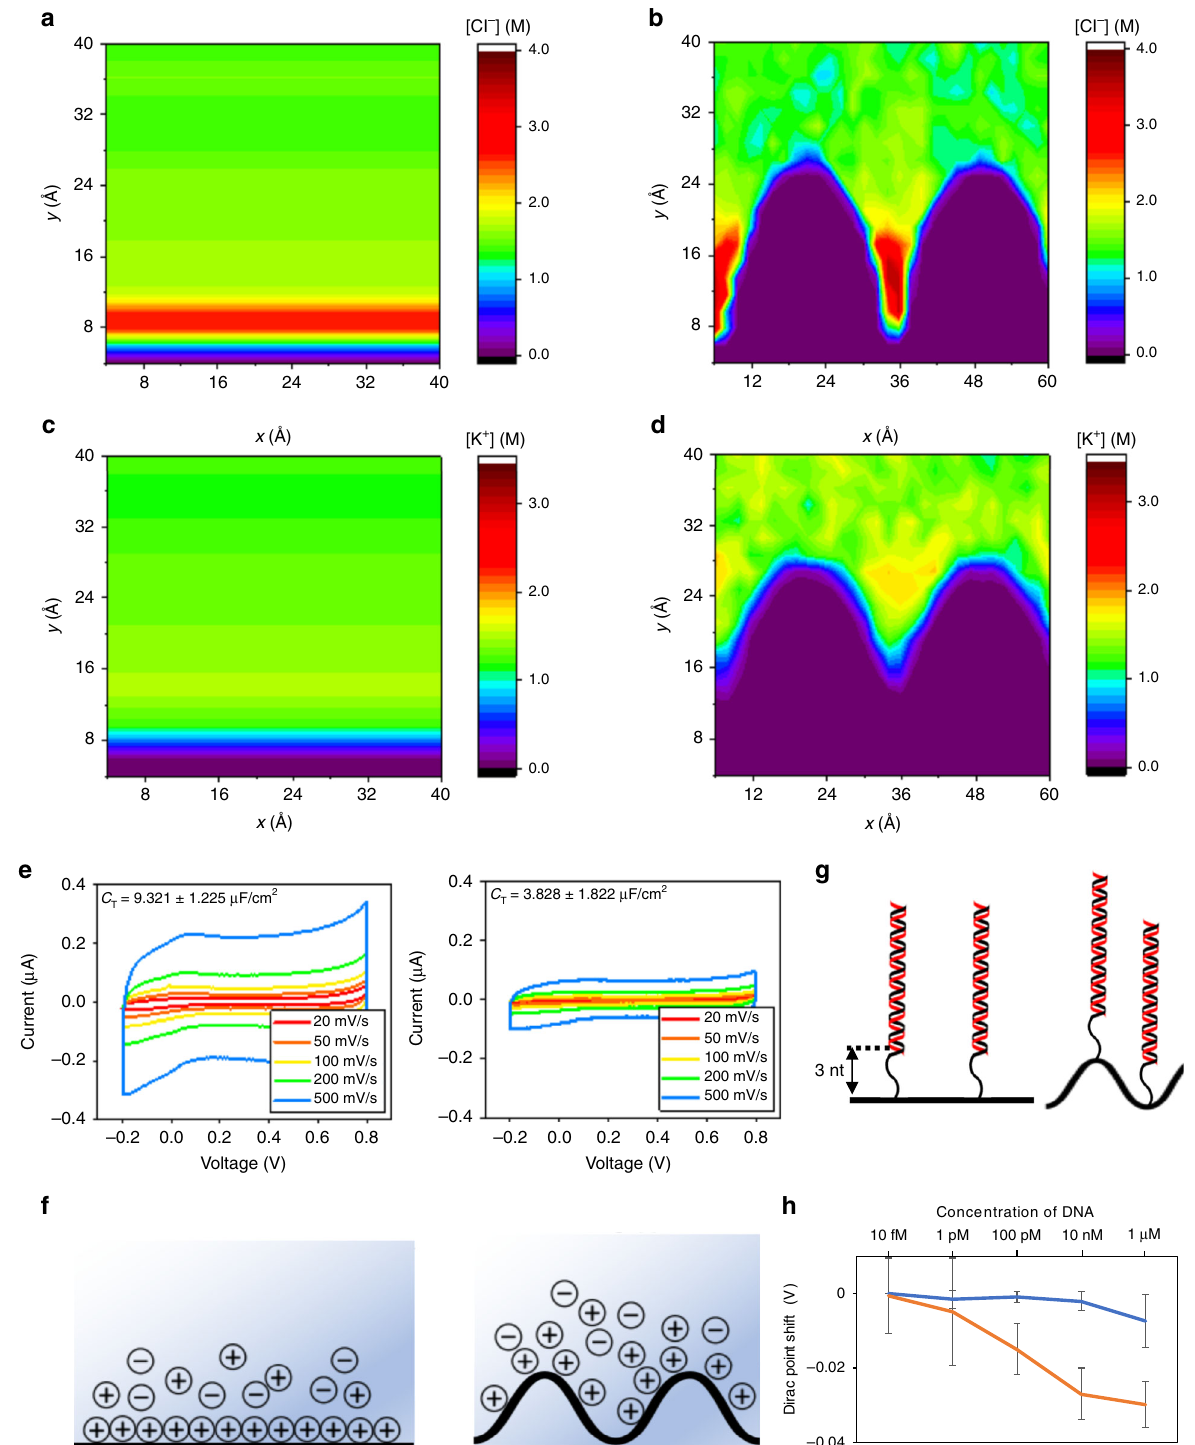
Fig. 4 Capacitance measurement and charge layer distance effect. a – d The molar concentration map of ions (sodium and chloride) are plotted for fl at and crumpled charged graphene sheet. The counter-ions are distributed over a longer distance away from the surface of graphene in the concave region of the crumpled graphene. e EDL capacitance of fl at and crumpled graphene. As EDL of the fl at graphene is denser than the crumpled graphene, fl at graphene had about three times larger capacitance than crumpled graphene. f ELD structures of fl at (left) and crumpled graphene (right). Loosely structured EDL of crumpled graphene leads to the smaller capacitance value. g To determine if the crumpled graphene device has longer Debye length, distance of double strand (probe + target) DNA part was 3 nt further from the surface. h The fl at graphene device (blue line) is not able to measure the 19 nt (3 nt short) target DNA while, the crumpled graphene (the orange line) showed left shift of IV curves. n = 3, mean ±